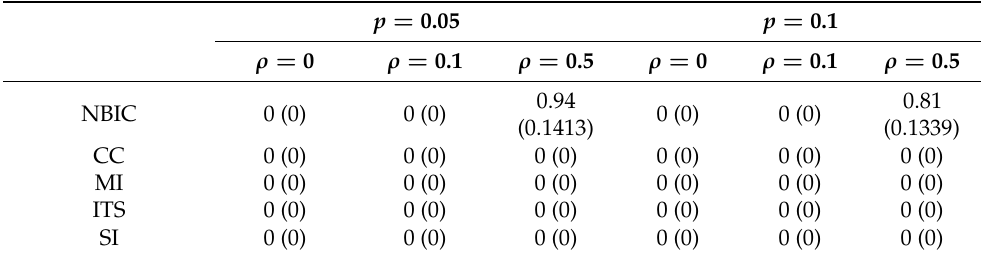
Table A4. Average number of incorrectly omitted variables, and its standard error over 100 simulated